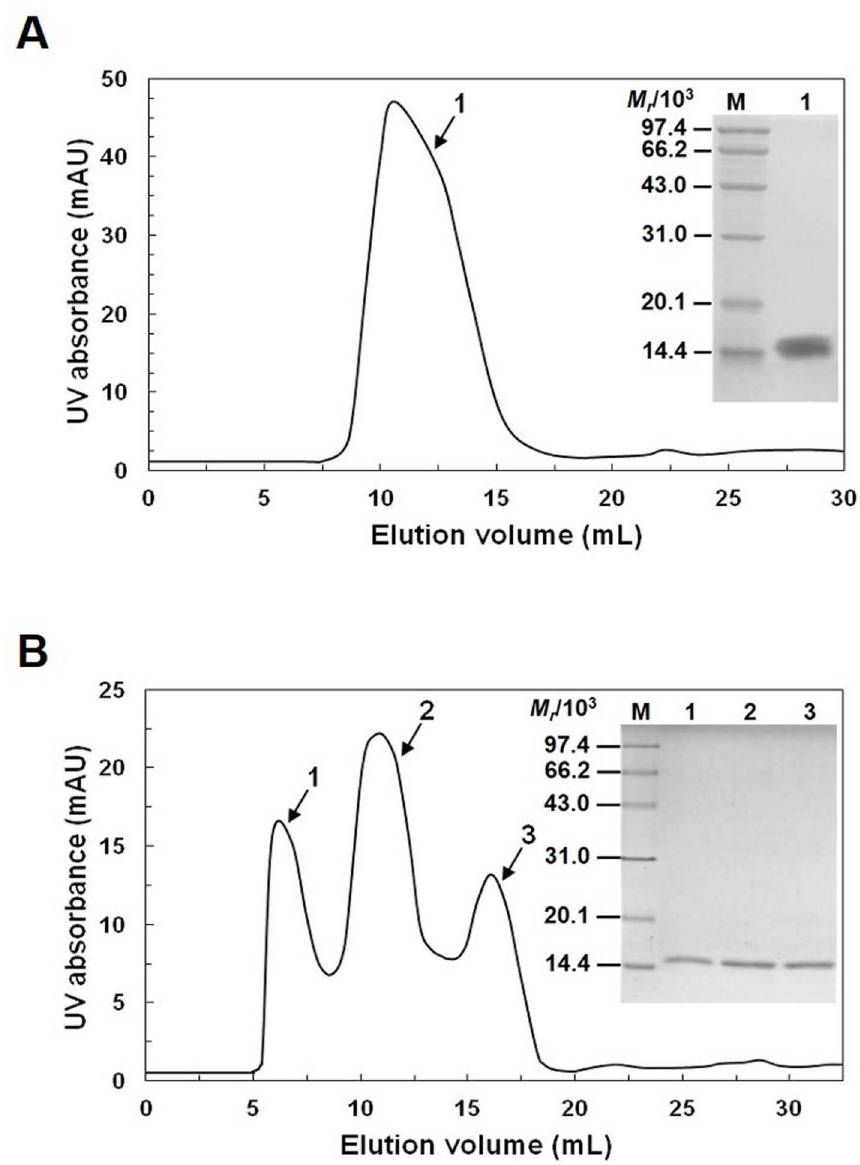
Fig 2. Isolation of native LYZL6 from human sperm extracts. A) Elution profile of chitin affinity chromatography. Inset: SDS–PAGE of the chitin column peak. Lane M: MW marker; Lane 1: peak 1. B) Elution profile of anion exchangechromatography. Inset: SDS–PAGE of the HiTrap Q column peaks. LaneM: MW marker; Lane 1–3: peak 1, 2, and 3. Bands in the gel were identifiedby MS.